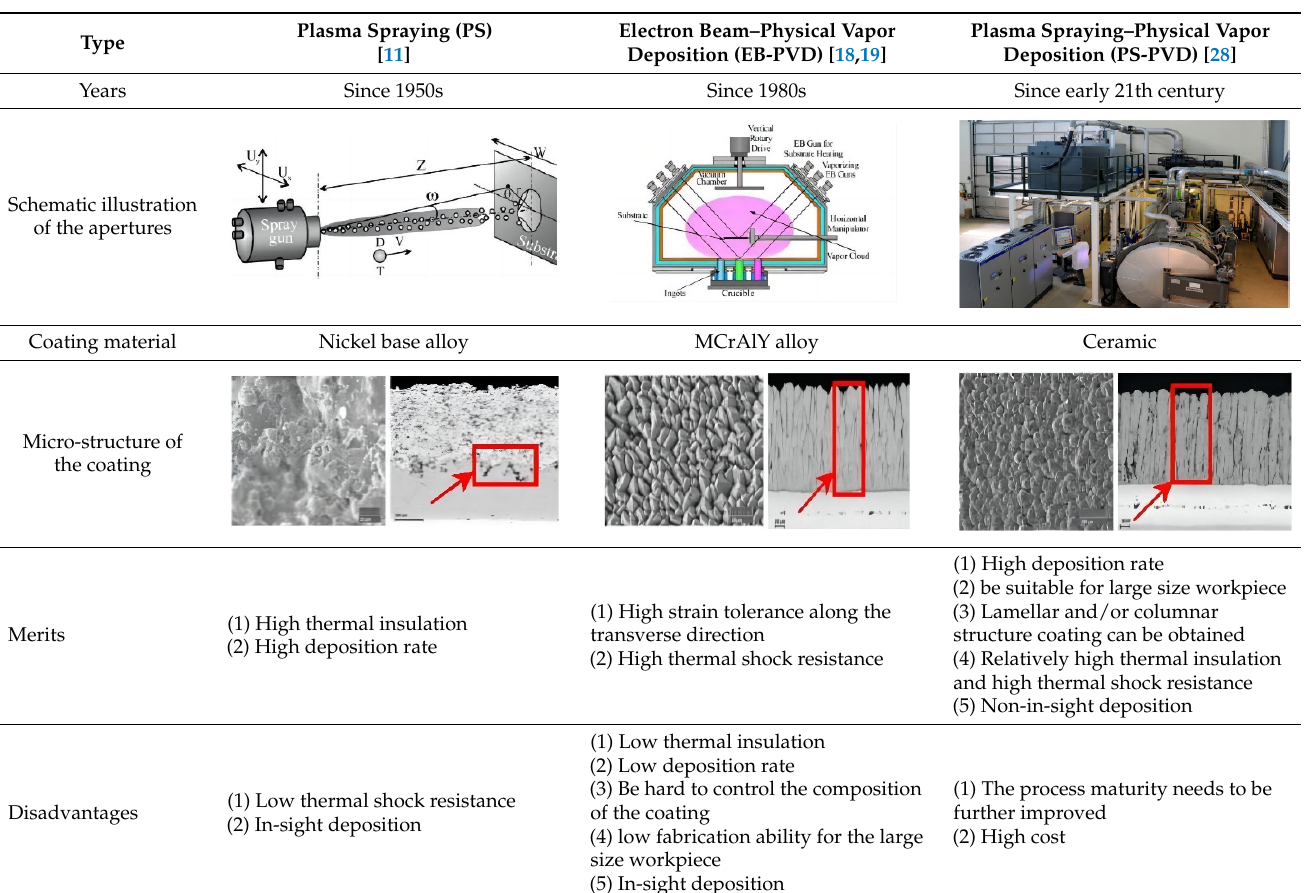
Table 1. Difference of the thermal barrier coatings fabricated by three different processing techniques [11,18,19,28].